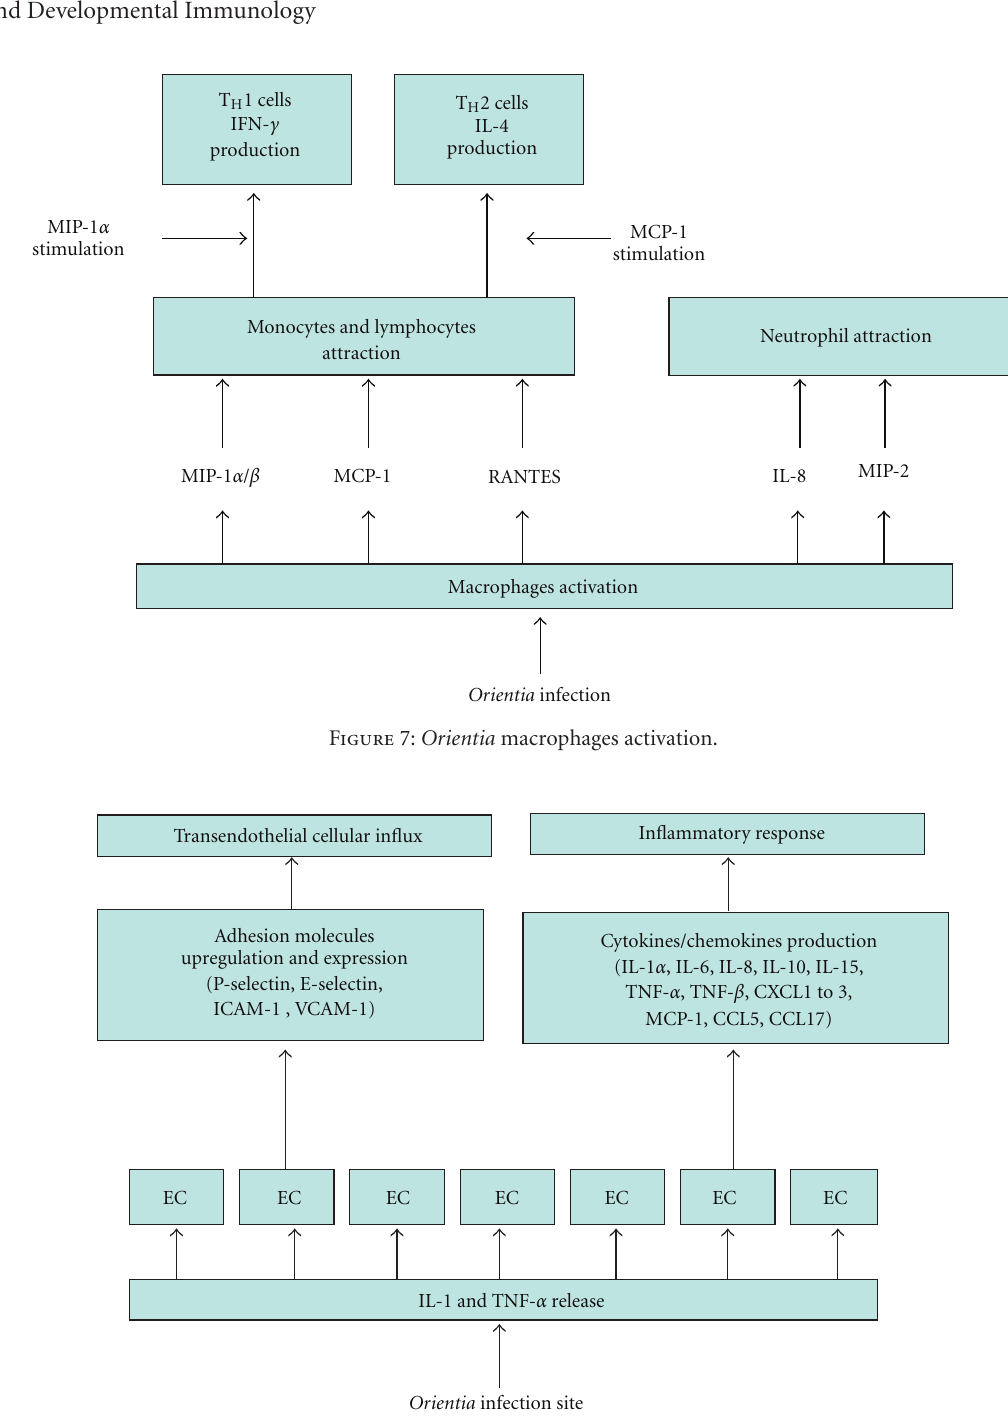
Figure 8: Orientia endothelial cells